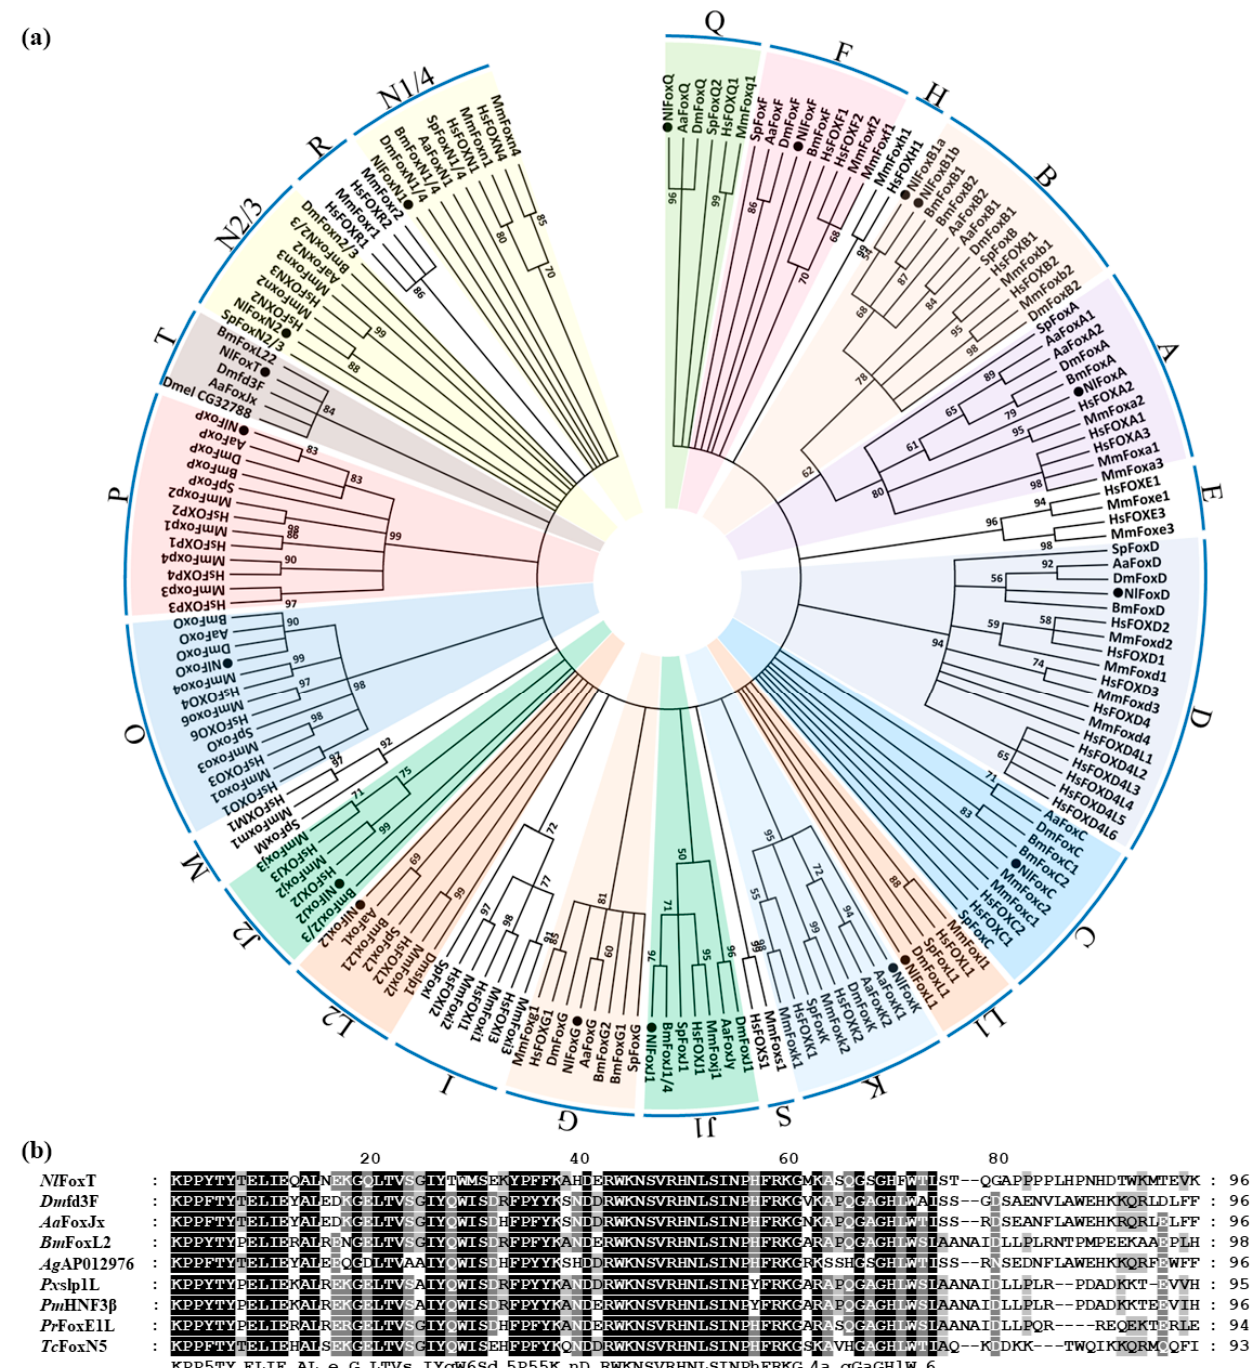
Figure 1. Several insect Fox genes clustered to form an insect-specific branch. ( a ) Phylogenetic analysis of Fox proteins. The tree was constructed using MEGA7 software with the maximum likelihood method. A bootstrap analysis of 1000 replications were conducted, and bootstrap values (%) are presented in the cladogram. For condensing the tree, 50% cut-off values were used. Different subfamilies in N. lugens were painted in different colors. ( b ) Alignment of amino acid sequences of FHD from insect-specific Fox genes. Nl: Nilaparvata lugens , Hs: Homo sapiens , Mm: Mus musculus , Sp: Strongylocentrotus purpuratus , Dm: Drosophila melanogaster , Bm: Bombyx mori , Aa: Aedes aegypti , Ag: Anopheles gambiae , Px: Papilio xuthus , Pm: Papilio machaon , Pr: Pieris rapae , Tc: Tribolium castaneum .